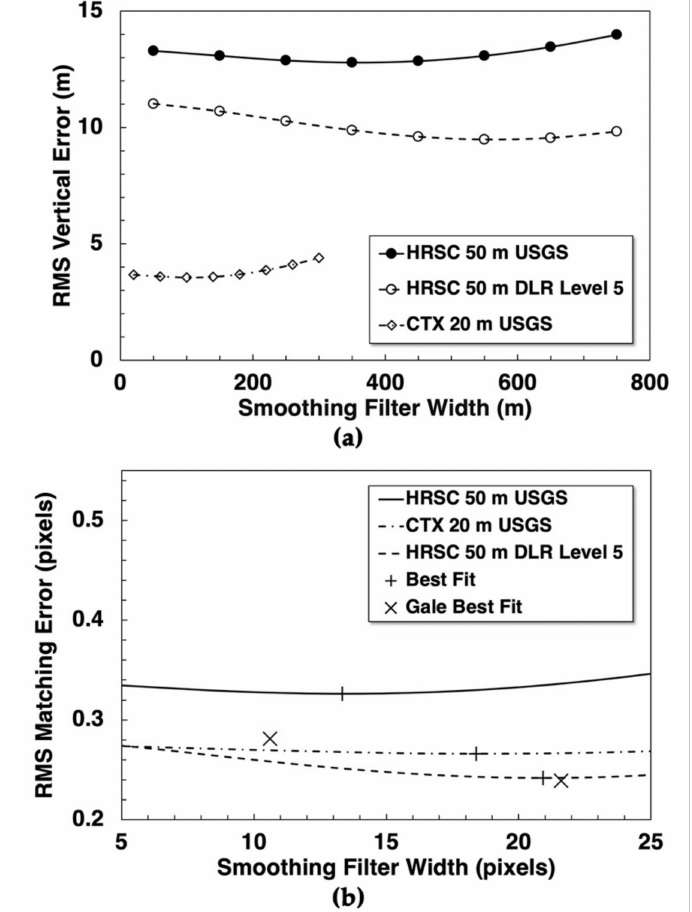
Figure 5. Estimated matching error of target DTMs as a function of smoothing of reference DTM. ( a ) Filter width and RMS vertical difference in meters. Values for odd-integer filter widths are shown, connected by a smooth curve. ( b ) Filter width and error nondimensionalized in terms of stereo channel GSD and stereo parallax/height ratio as described in text. Curves through data are shown with crosses indicating the interpolated minimum error at best-fit width. Xs indicate interpolated minima for Gale crater results [10,11] with DLR point to right of that for USGS DTM. Table 2. DTM normalized resolution and error as a function of surface